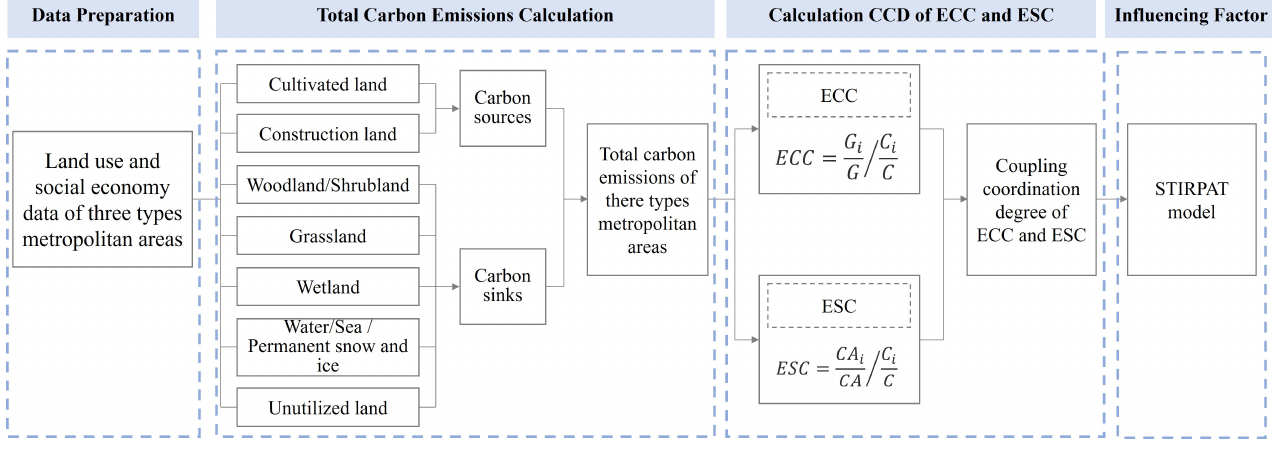
Figure 2. Research framework.